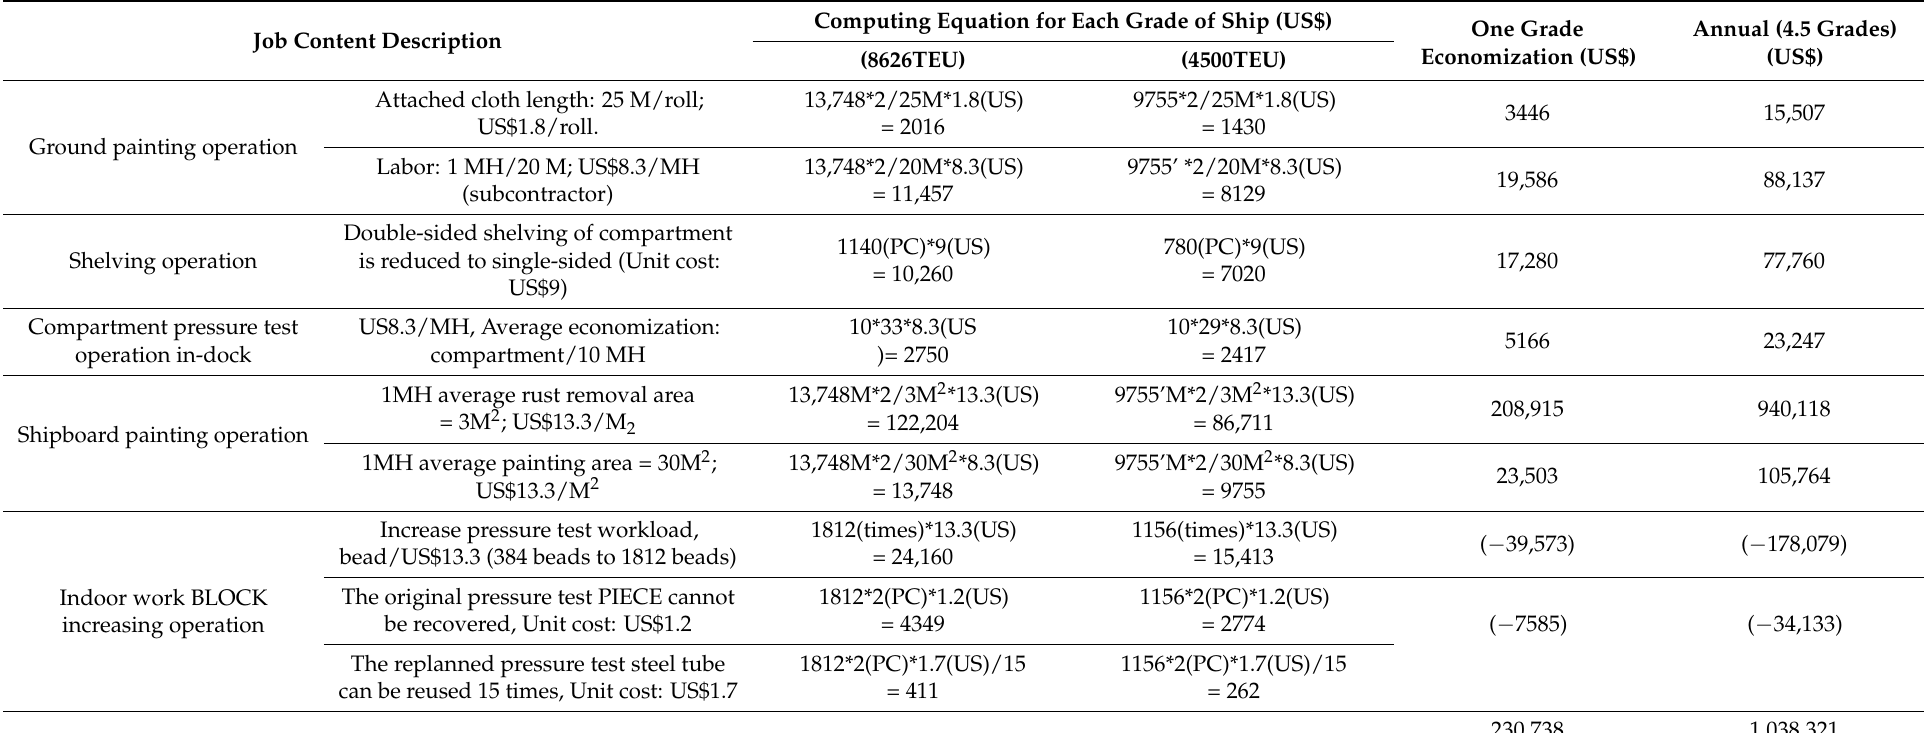
Table 2. Total benefit statistics (compared with sister